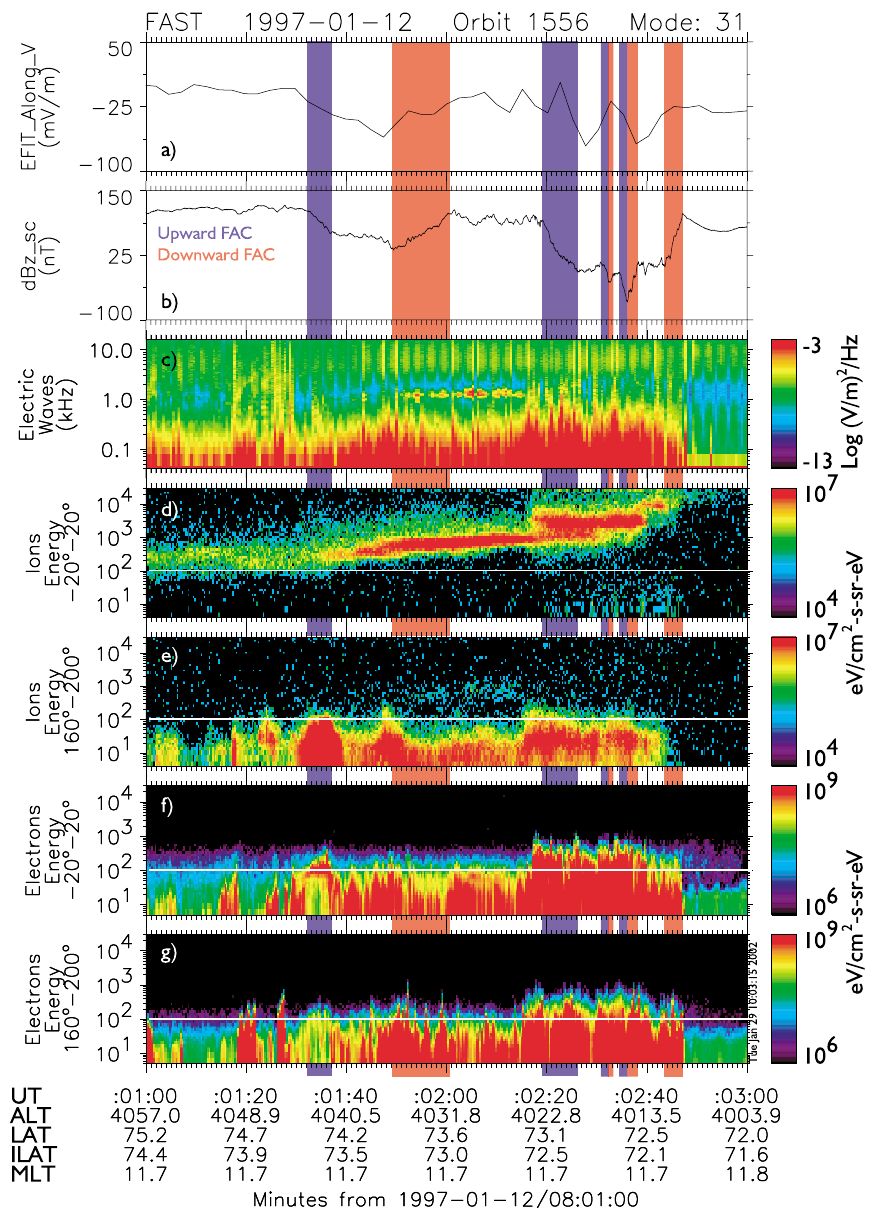
Fig. 6. An expanded view from 08:01 to 08:03 UT of the FAST particle and field data in Fig. 4. The blue and red shadings indicate regions of upward and downward field-aligned currents (FAC),